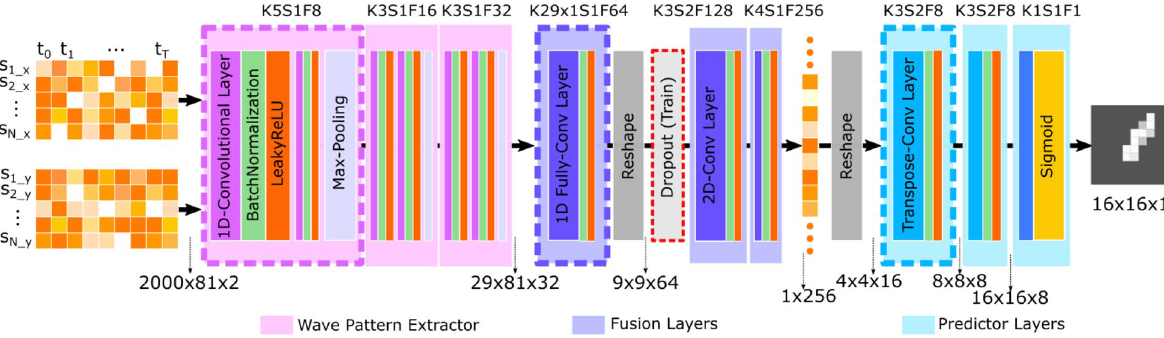
Figure 3. Detailed design of the damage detection model. The shape of input data and layer output is placed at the bottom; layer configurations are placed on top for each